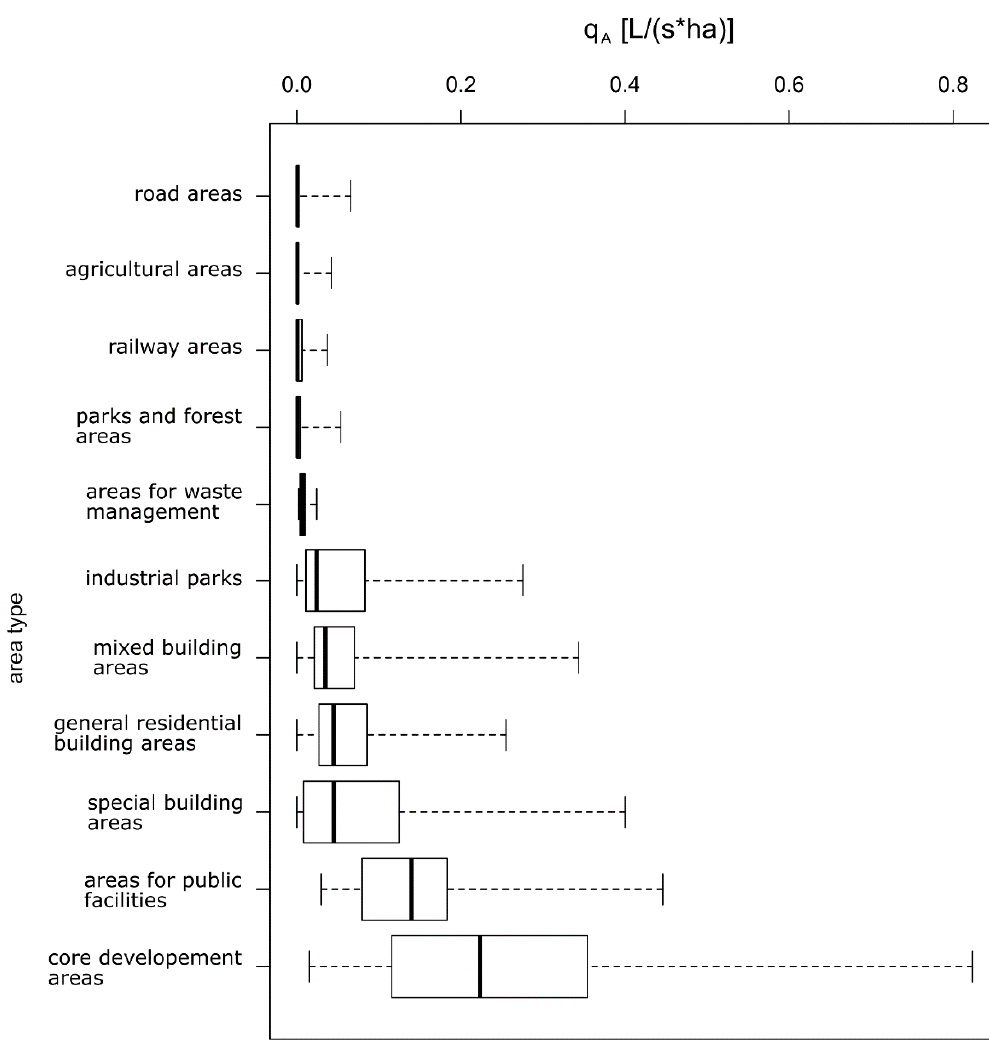
Figure 8. Boxplots of wastewater yield factors for typical categories of a LUP.